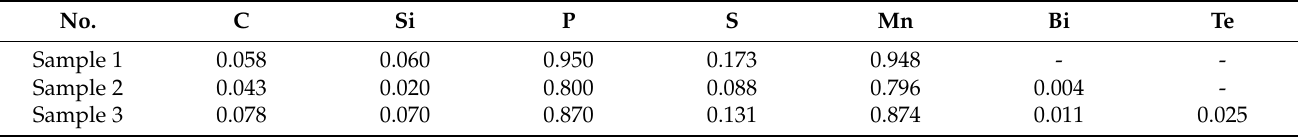
Table 1. Chemical composition of 3 kinds of test steels (mass fraction, %).